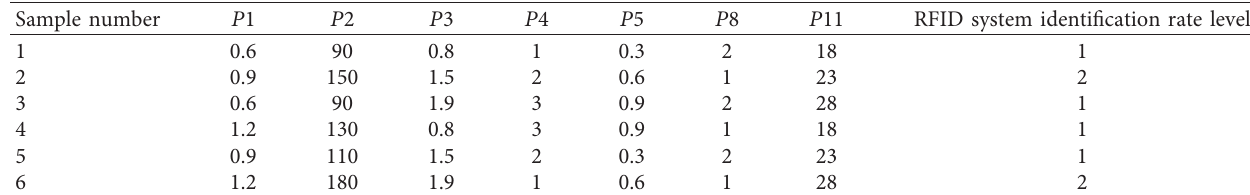
Table 4: Samples of the RFID system identification rate.